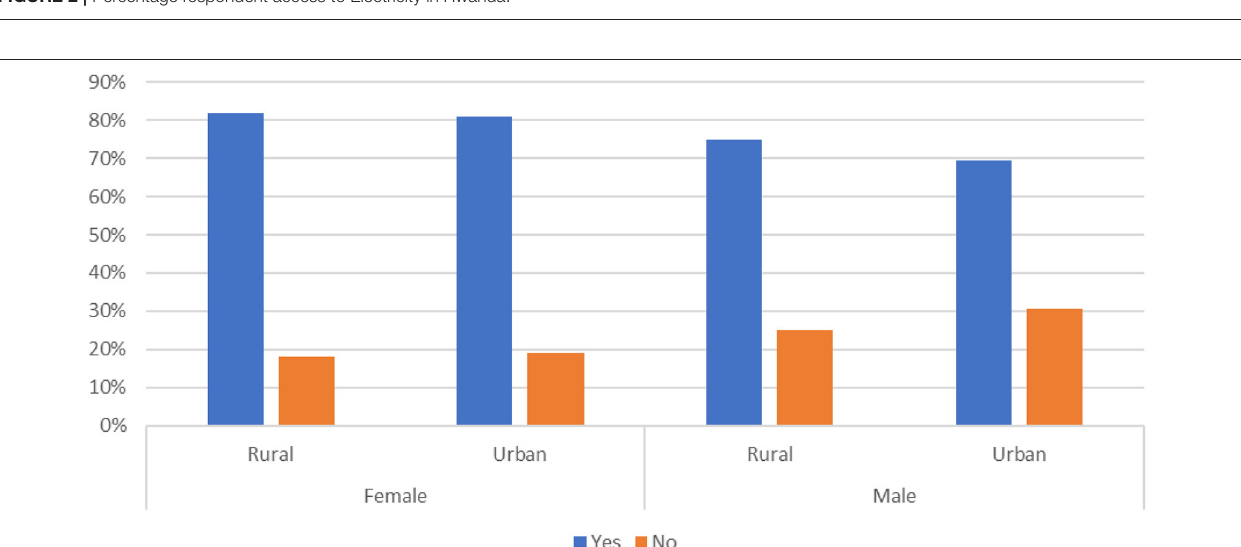
FIGURE 2 | Percentage respondent access to Electricity in Rwanda.